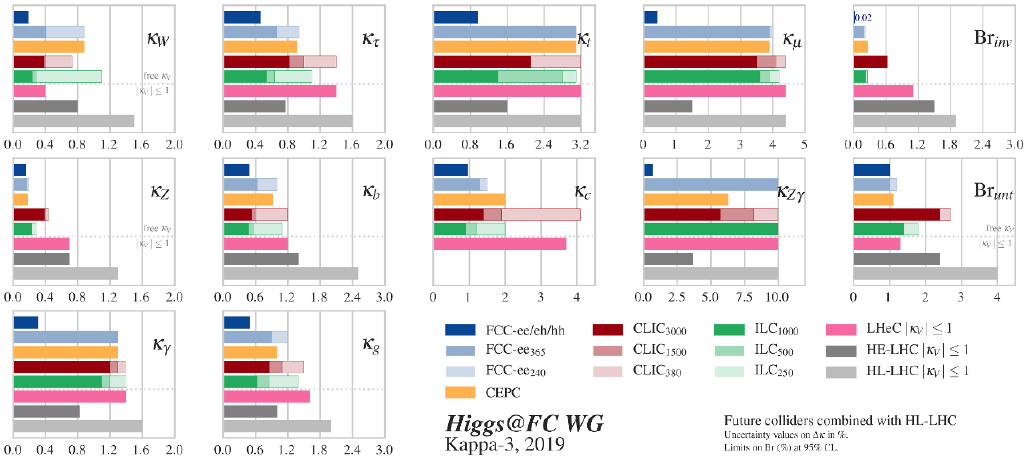
Figure 2 . Expected relative precision (%) of the (cid:20) parameters in the kappa-3 scenario described in section 2. For details, see tables 4 and 5. For HE-LHC, the S2’ scenario is displayed. For LHeC, HL-LHC and HE-LHC a constrained (cid:20) V (cid:20) 1 is applied. between these and the untagged branching fraction (30{50%). The correlations between (cid:20) b , (cid:20) (cid:28) , (cid:20) g and (cid:20) W are mild, with the largest value corresponding once again to (cid:20) b and (cid:20) (cid:28) (74%).